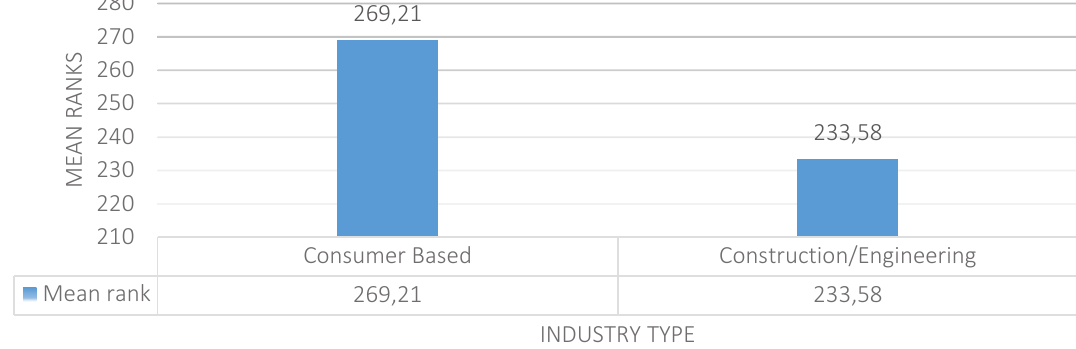
Figure 5. “Focus level” mean rank by industry type